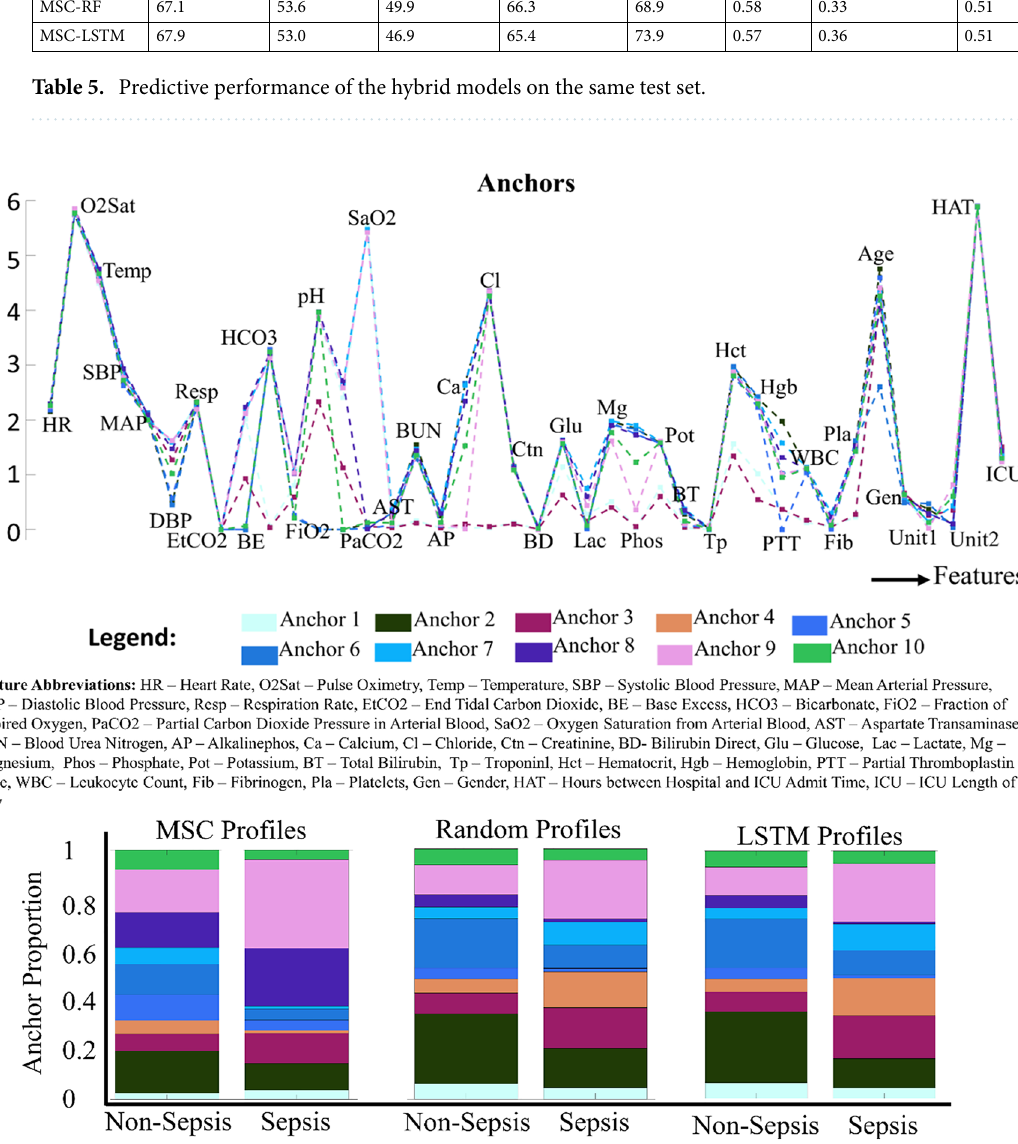
Figure 4. The MSC model and the hybrid models all use the same anchors illustrated and overlaid here to allow valid comparison. The sepsis (and non-sepsis) class profiles created from these 10 anchors by MSC, MSC-RF, MSC-LSTM models, respectively are also displayed. While the profiles for each class for both hybrid models look similar, they differ significantly from the sepsis profiles obtained from